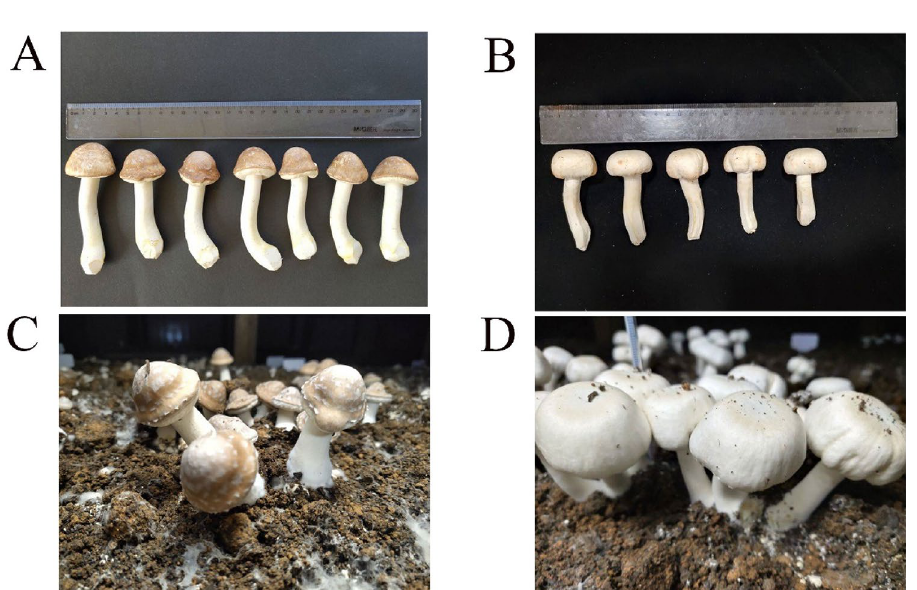
Figure 1. ( A ) The shape of J1’s fruiting body; ( B ) The shape of J77’s fruiting body; ( C ) The form of J1’s fruiting body during cultivation; ( D ) The form of J77’s fruiting body during